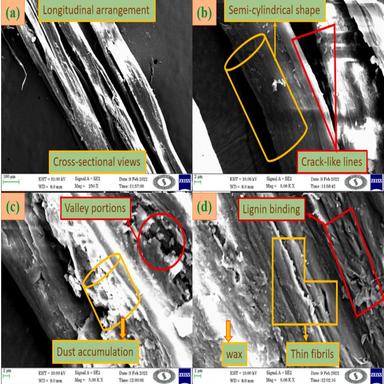
FESEM images of HRF (a) strands; (b) longitudinal view; (c) transverse view; and (d) inner core.